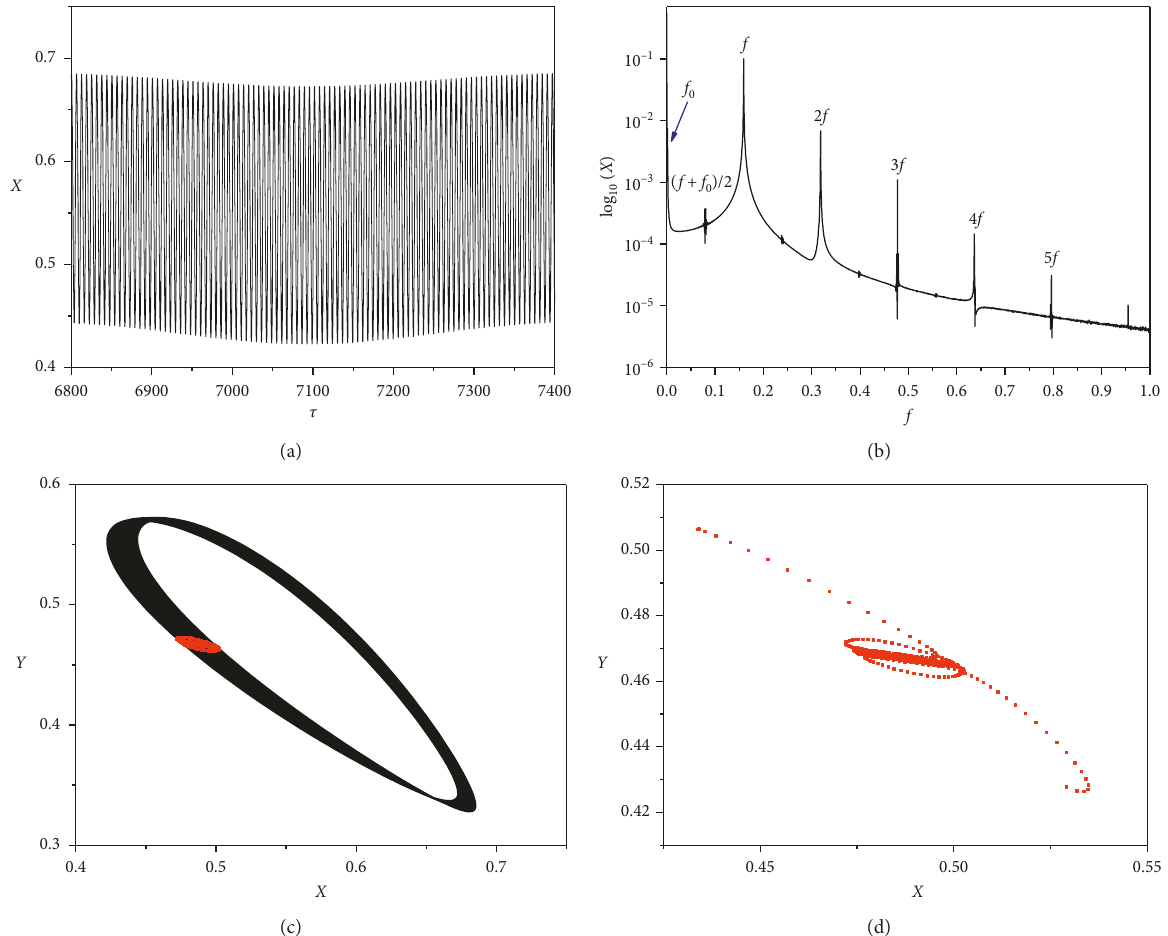
Figure 13: (a) Displacement. (b) Frequency response. (c) Rotor orbit. (d) Poincar´e map where